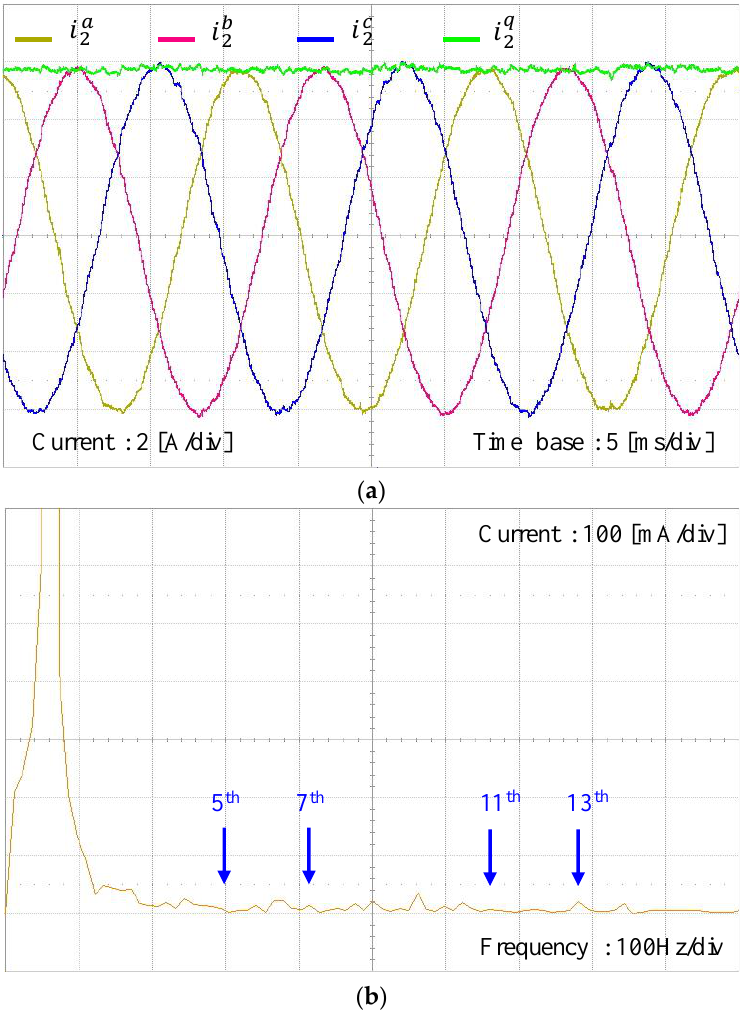
Figure 17. Experimental results for the proposed control scheme at steady-state. ( a ) Three-phase grid-side current waveforms; ( b ) FFT result for a -phase current.